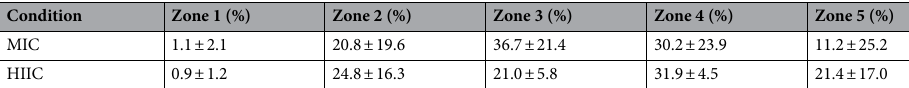
Table 2. Training load quantification of the MIC and work-matched HIIC protocols. Values presented as mean ± SD. MIC moderate intensity cycling; HIIC high intensity interval cycling; zone (%) % of session in specified heart rate zone. Zone 1: 50–59% of HR peak , Zone 2: 60–69% of HR peak , Zone 3: 70–79% of HR peak , Zone 4: 80–89% of HR peak and Zone 5: ≥ 90% of HR peak